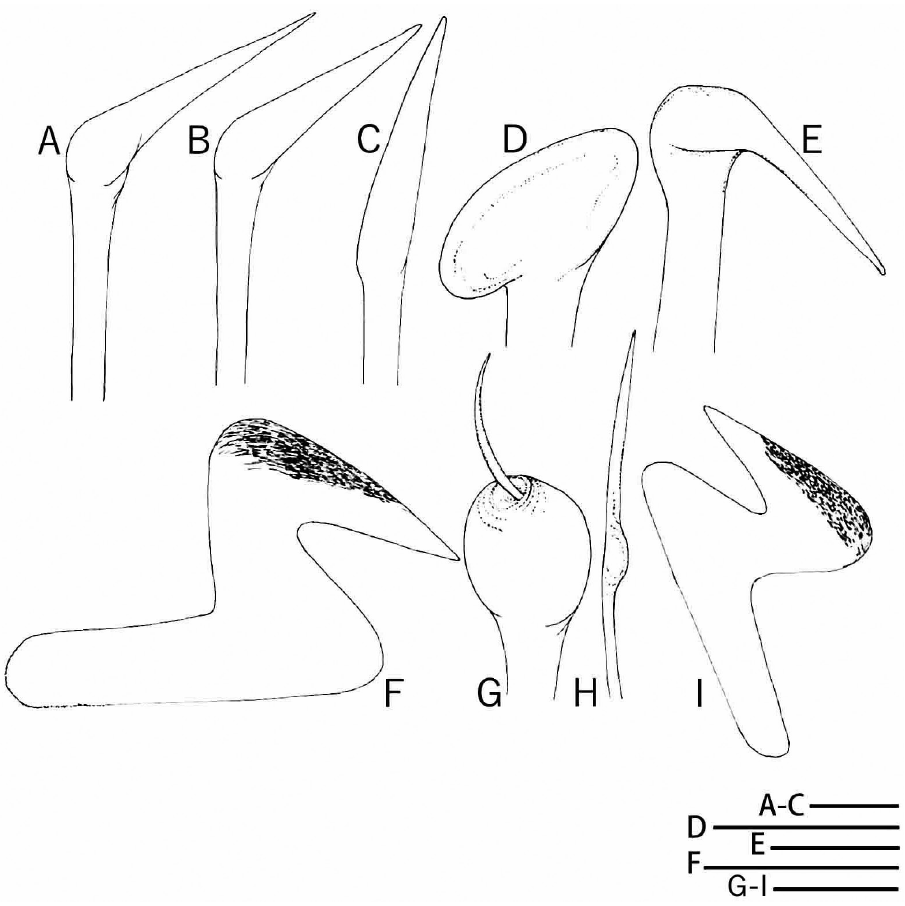
Figure 2. Notaulax yamasui sp. n. Chaetae of thorax ( A–E ) and abdomen ( G, H ) drawn from SEM micrographs, and uncini ( F, I ), drawn under a dissecting light microscope. A–B collar chaetae C superior thoracic chaeta D inferior thoracic chaeta E companion chaeta, dorsal view F thoracic uncini G inferior abdominal chaeta, anterior abdominal chaetiger H inferior abdominal chaeta, posterior abdominal chaetiger I abdominal uncini. Scale bars 20 µm ( A–C ), 50µm ( D ), and 30µm ( E–I